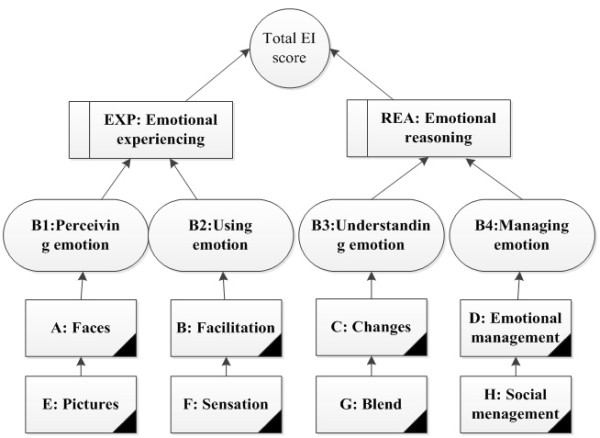
The MSCEIT scores.